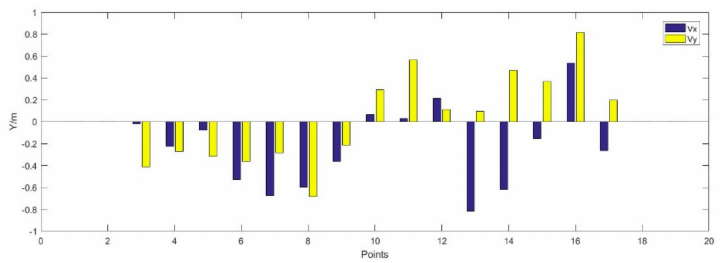
Figure 12. Error of the UWB anchors after adjustment.